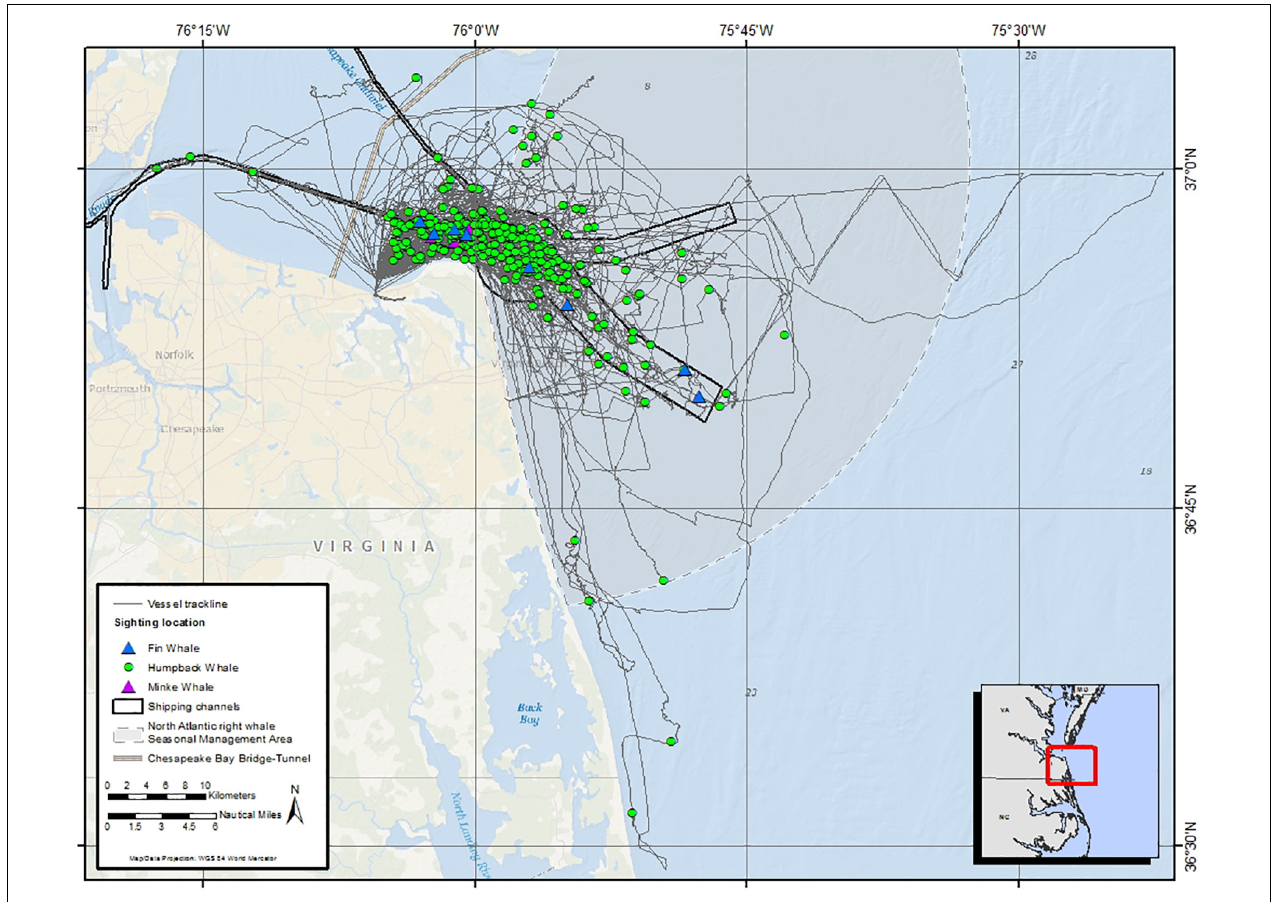
FIGURE 3 | Survey vessel trackline (gray line) and sightings of baleen whales for all field effort from December 2015 to February 2017, with humpback whales shown as green dots, minke whales shown as purple triangles, and fin whales shown as blue